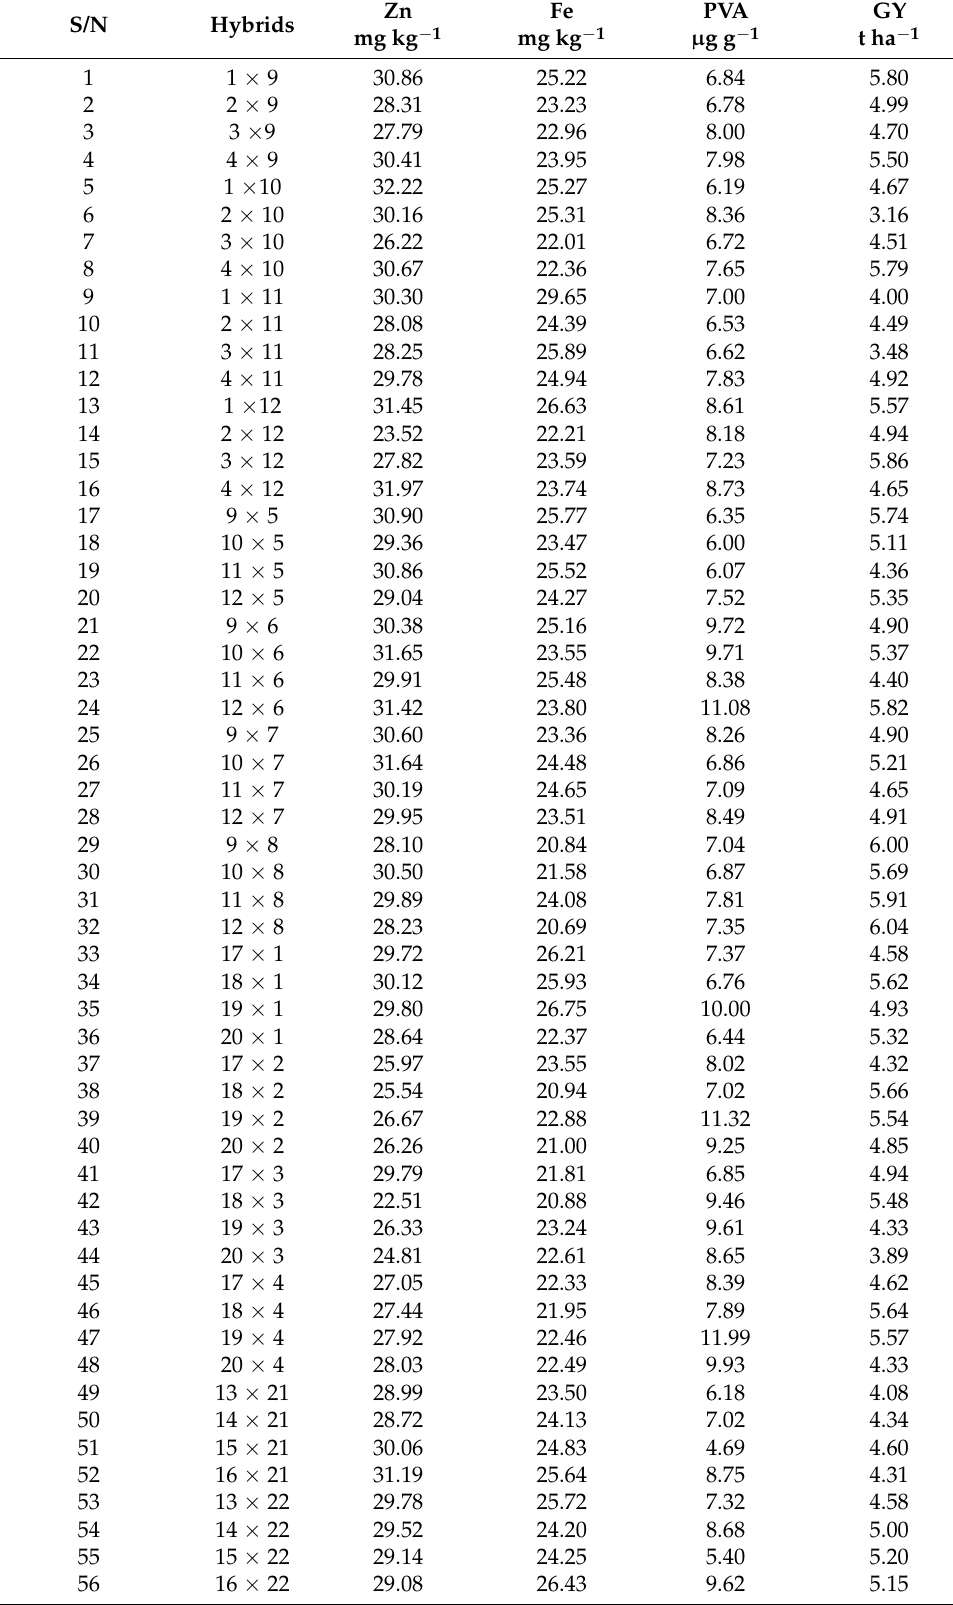
Table 3. Mean values for micronutrients content and grain yield for 96 hybrids and four checks evaluated across